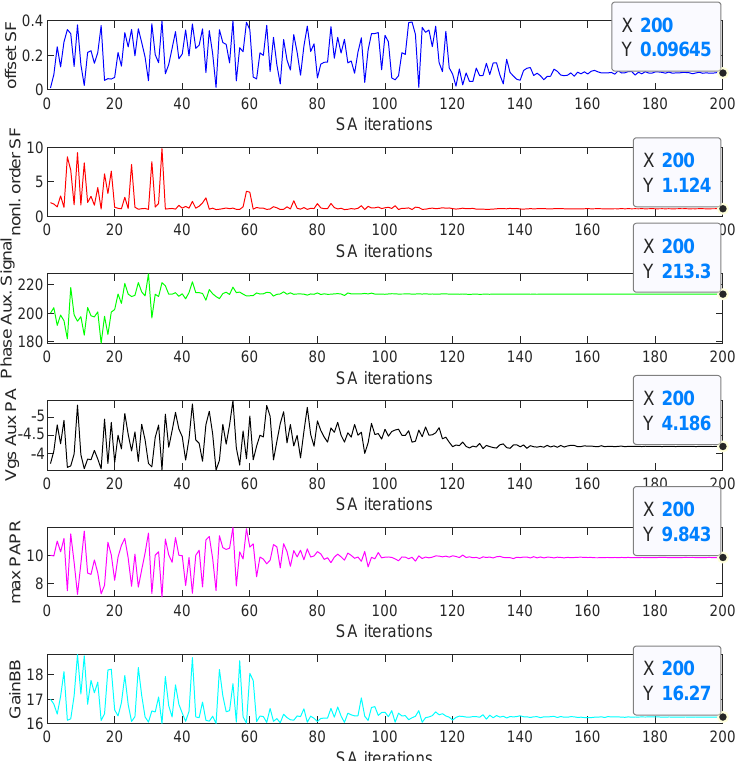
Figure 11. Evolution of the parameter values for different SA iterations for the CA-4 × LTE-20 signal test case.